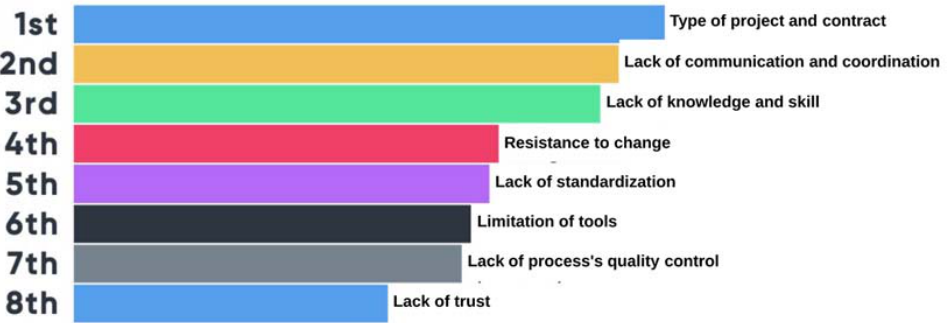
Figure 4. Ranking of the sources of waste validated in order of impact.